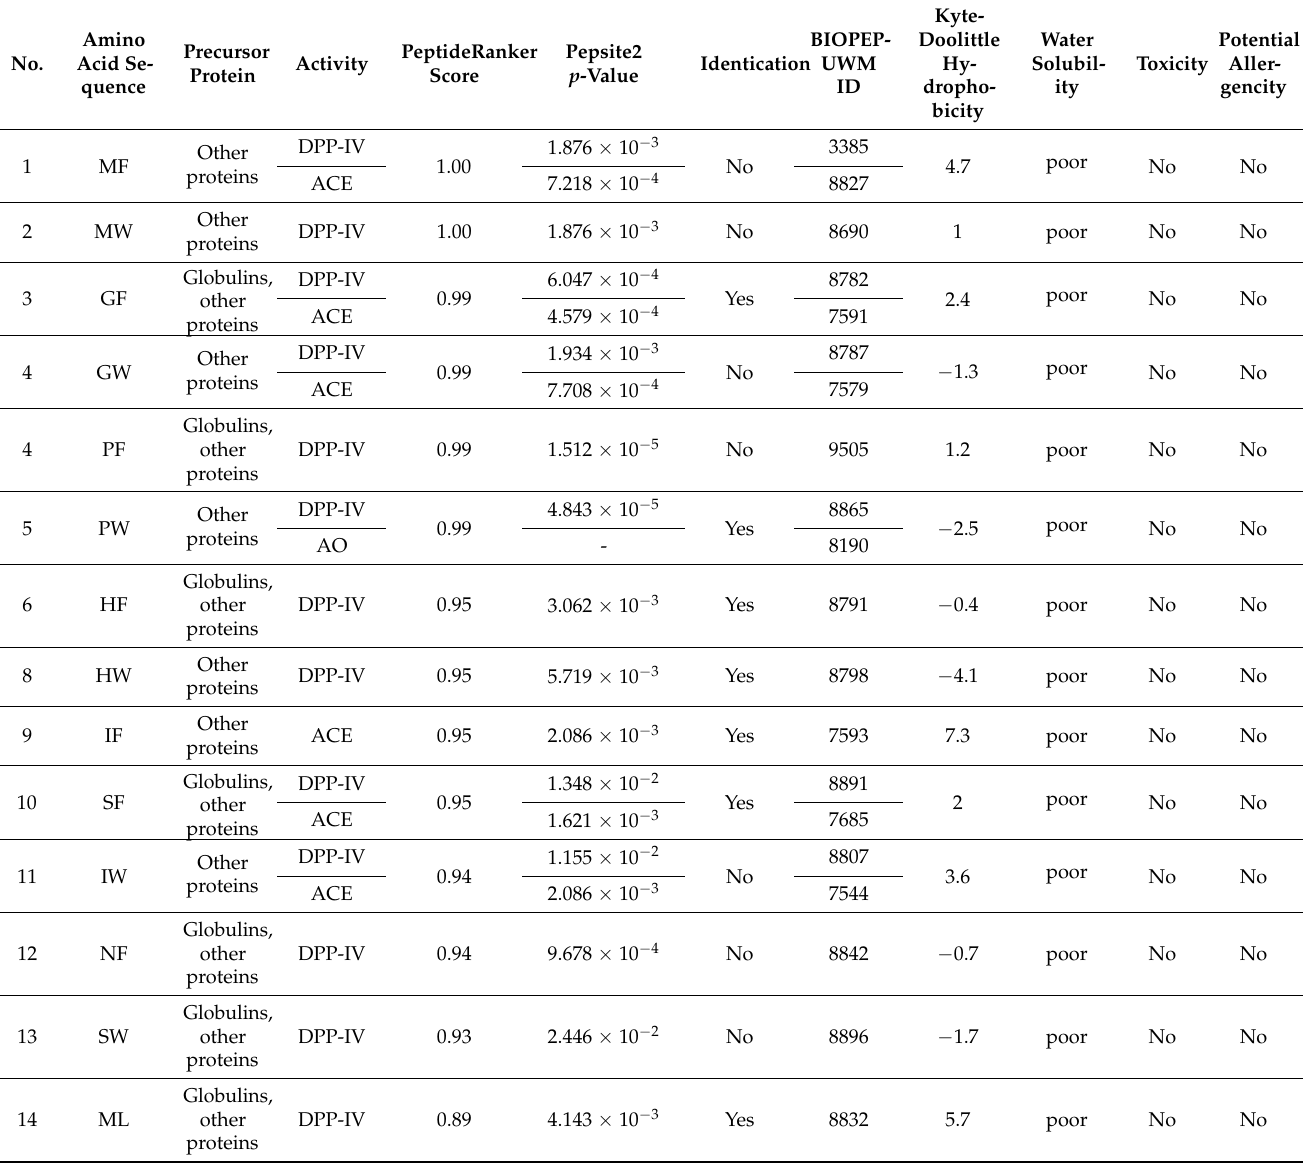
Table 2. The predicted amino acid sequences and properties of dipeptidylpeptidase (DPP-IV), angiotensin converting enzyme (ACE)-inhibiting, and antioxidative (AO) peptides matching the oat kernel protein sequences that were selected for the LC-MS/MS identification in the oat kernel digests (see Materials and